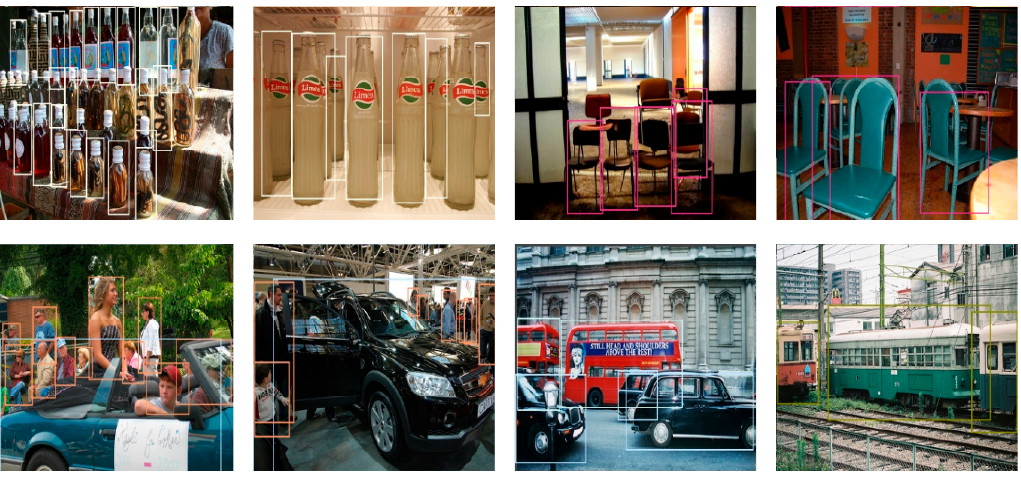
Figure 5. Detection results of GC-YOLOv3.